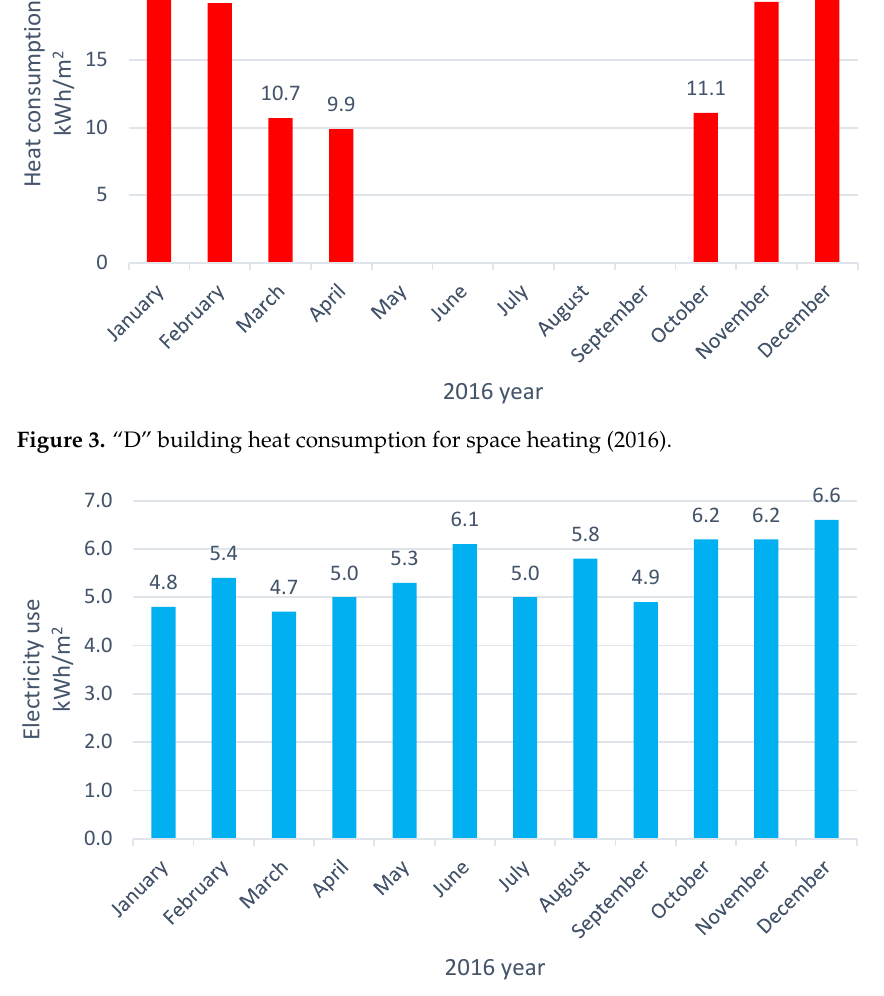
Figure 4. “D” Electricity consumption of the building (2016 year Figure 4. “ D ” Electricity consumption of the building (2016 year data).